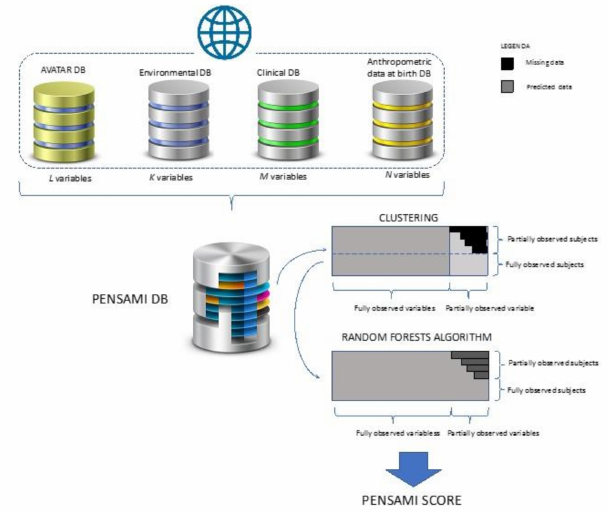
Figure 3. PENSAMI platform